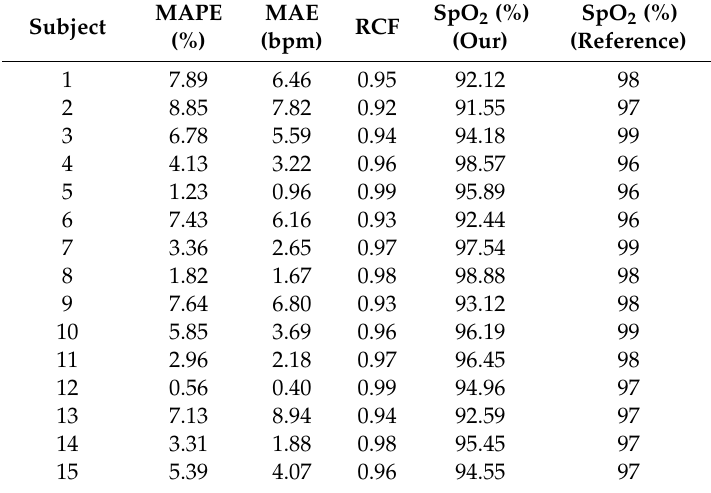
Table 3. Performance of our proposed wearable pulse oximeter device for the left-right finger motion condition.